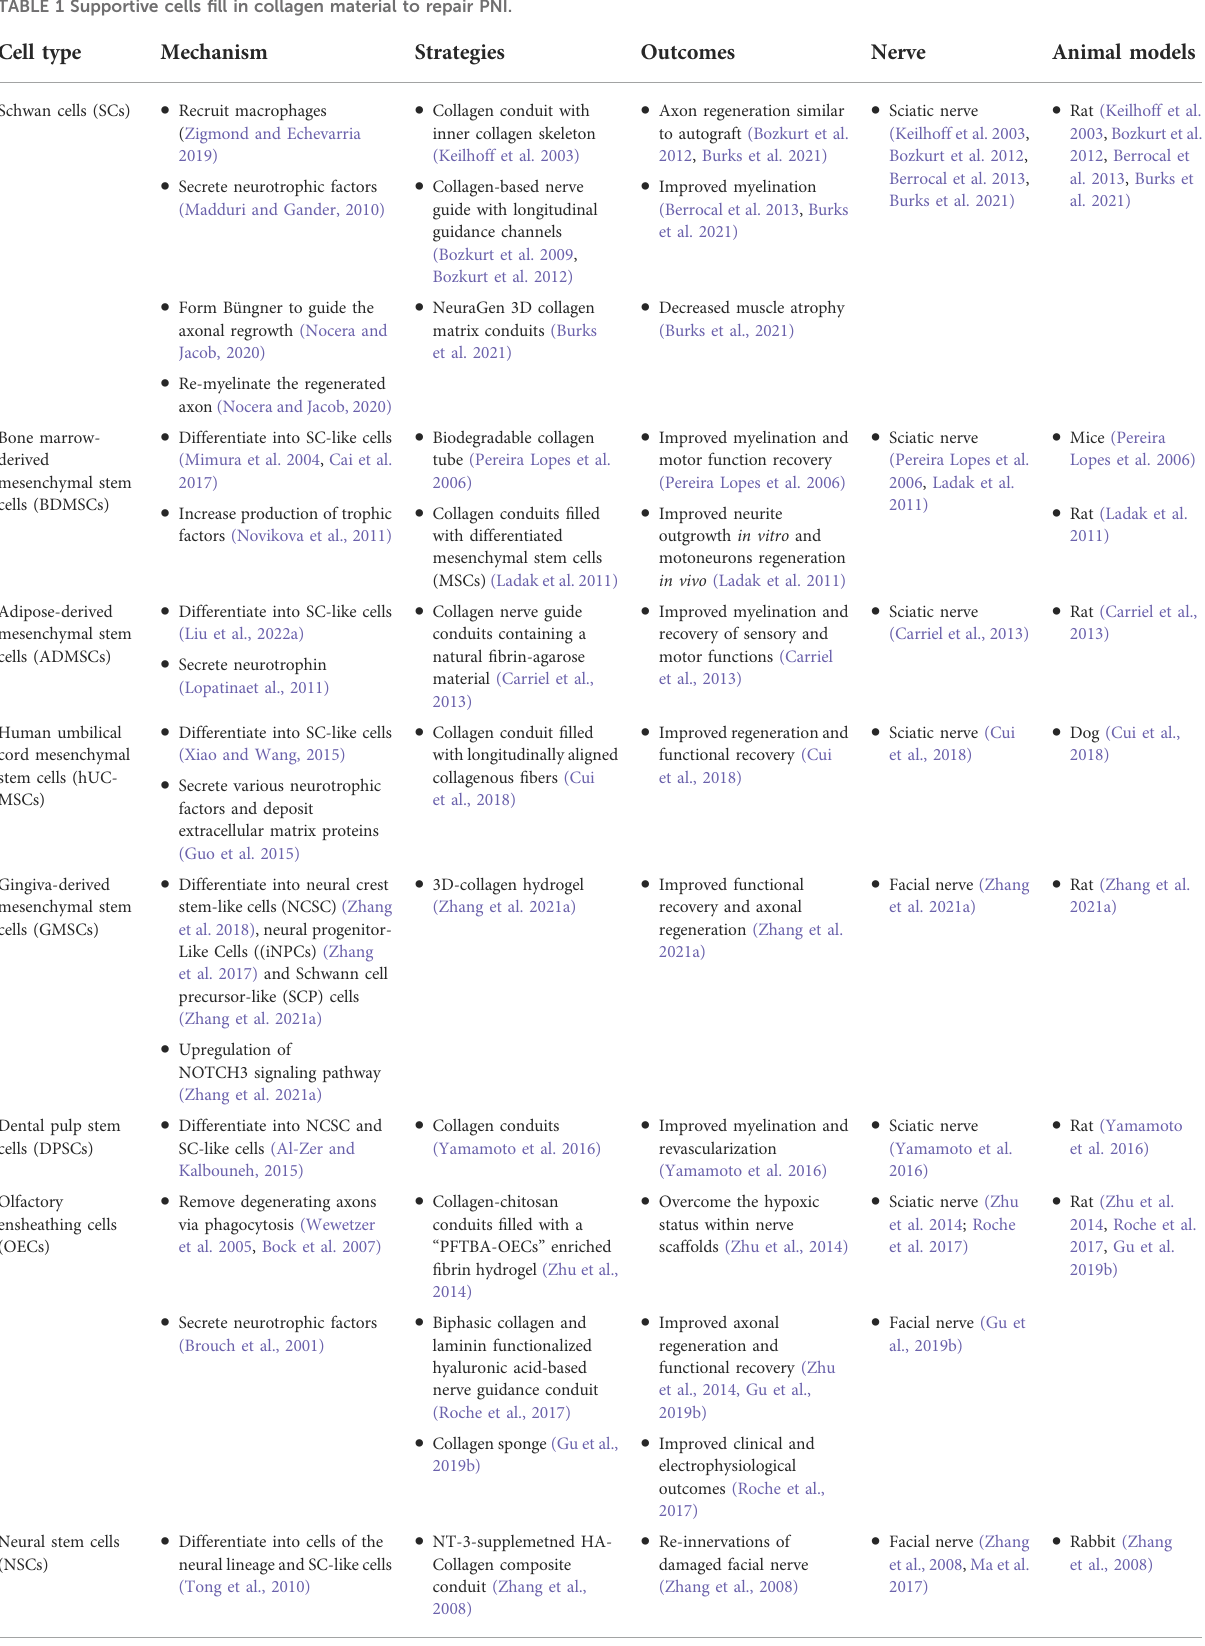
TABLE 1 Supportive cells fi ll in collagen material to repair